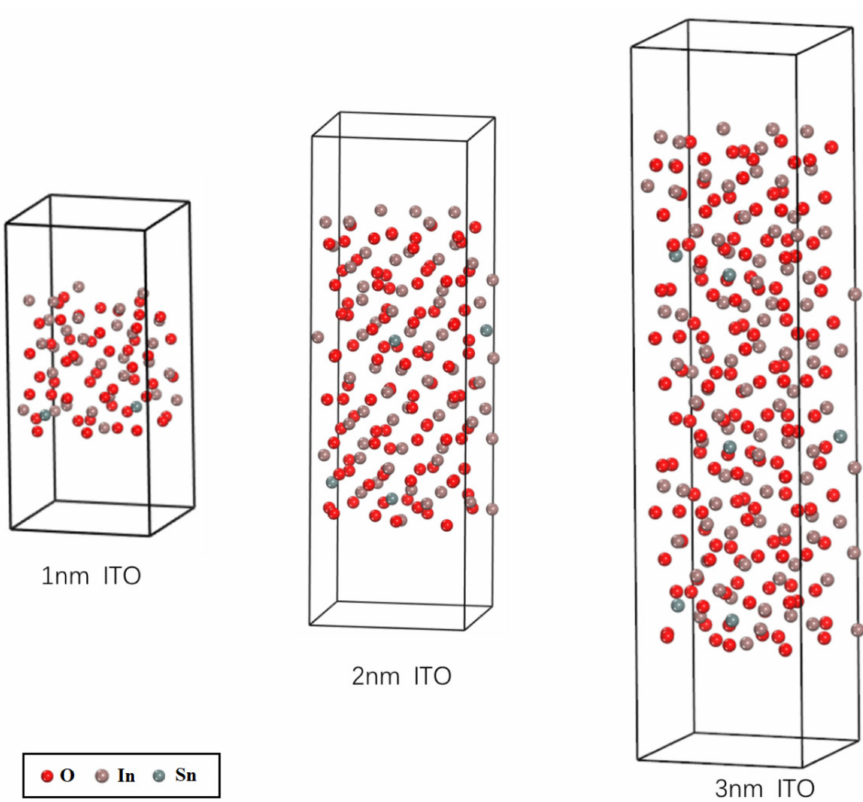
Figure 1. Simulated structures of indium tin oxide (ITO) with different thicknesses. The atomic structures are extracted from the molecular dynamics calculations at a random